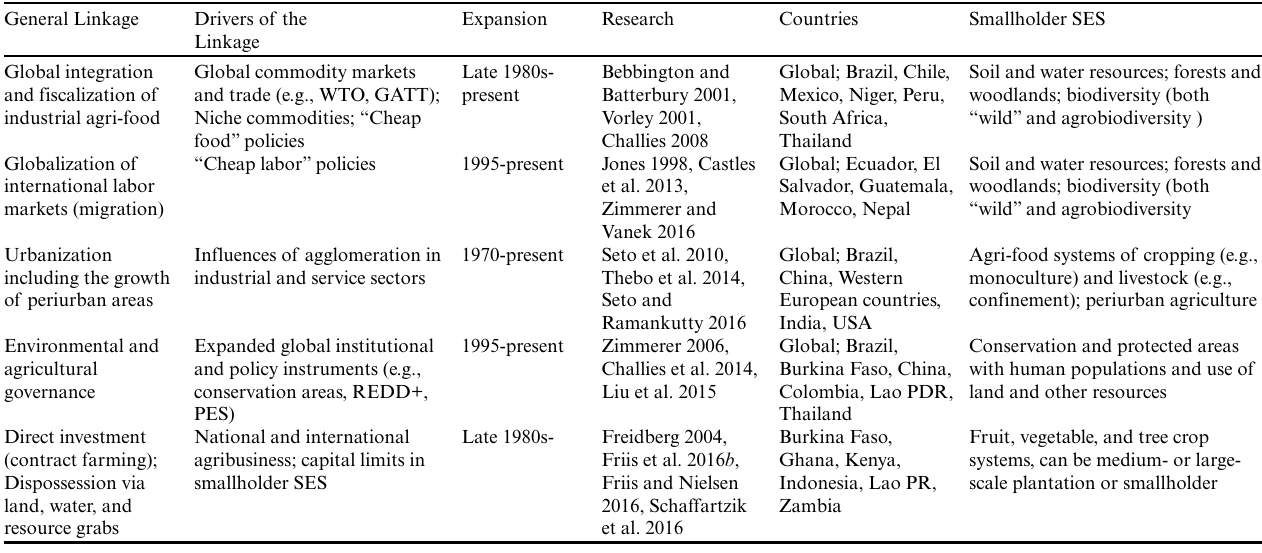
Table 1 . Examples of influential telecoupling linkages to smallholder social-ecological systems (SES). General